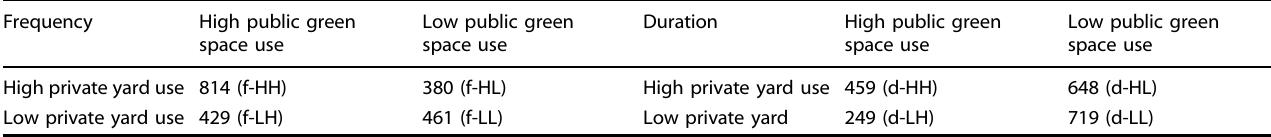
Table 1. Number of respondents in each of four quadrants of public and private green space use for frequency (f-) and duration (d-) of nature experiences.